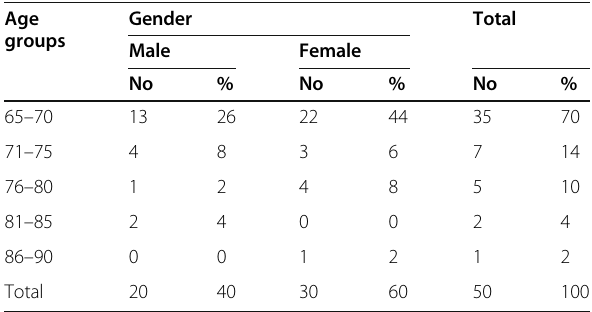
Table 1 Distribution of the studied patients according to age and gender ( n = 50)